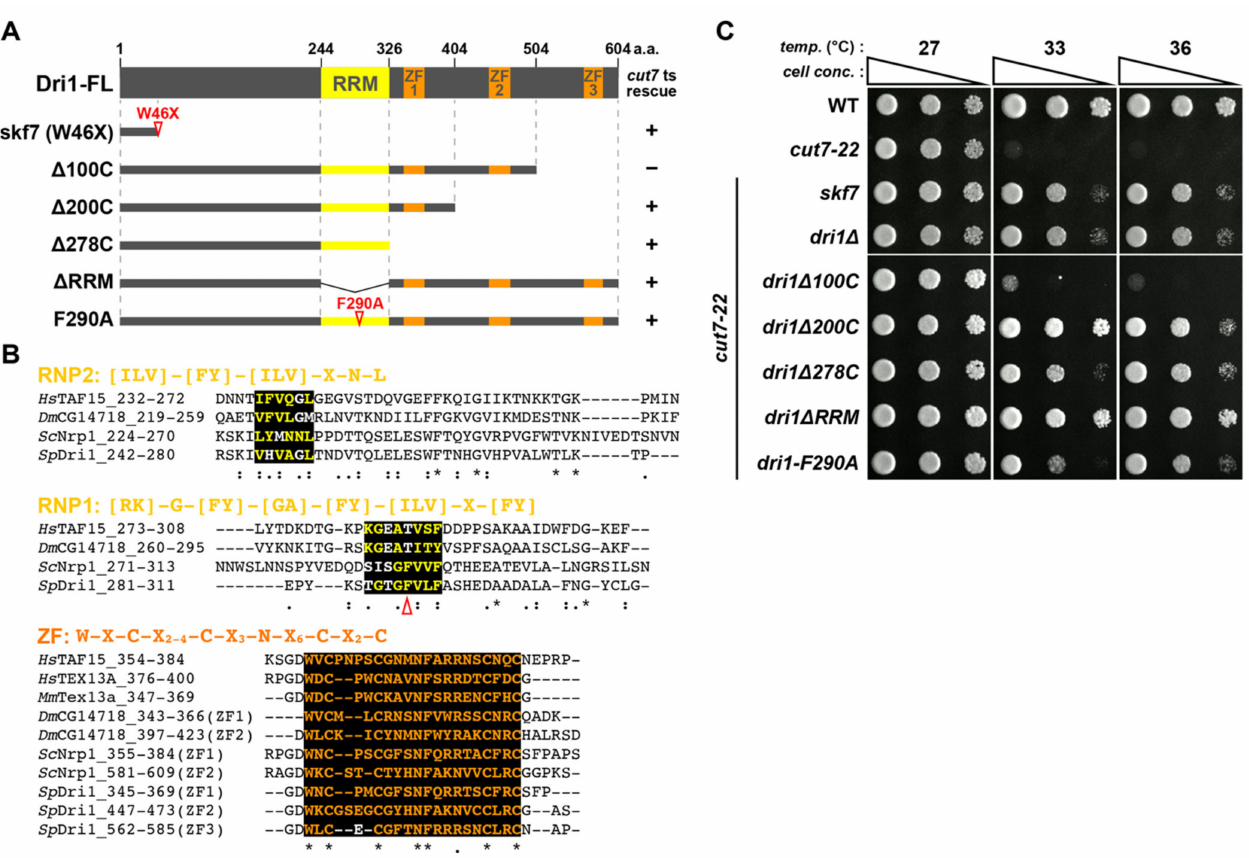
Figure 1. Systematic truncation and mutation analysis of Dri1 highlights the importance of RRM and RanBP2-type ZF domains. ( A ) Schematic representation of full-length Dri1 (Dri1-FL), skf7 mutant (W46X), C-terminal truncation mutants ( ∆ 100C, ∆ 200C, and ∆ 278C), an RRM truncation mutant ( ∆ RRM) and an RRM point mutant (F290A). The plus or minus sign indicates “rescue” or “no rescue”, respectively, of the cut7-22 ts phenotype by each dri1 mutant. ( B ) Dri1 is a member of the Tex13 protein family and is conserved across different species. Amino acid sequences from the indicated species have been aligned using the Clustal W. Consensus amino acids for the RRM (RNP1 and RNP2) or the RanBP2-type zinc finger domain (ZF) are highlighted in yellow or orange letters on black background, respectively. The conserved sequences are highlighted using symbols (asterisk represents identical residues; colon represents highly conservative residues; period represents moderately conservative residues). The F290A mutation is shown with an open arrowhead. Positions of amino acids used for H. sapiens TEX13A (376–400), M. musculus Tex13a (347–369), D. melanogaster CG14718 (219–295, 343–366 and 397–423), S. cerevisiae Nrp1 (224–313, 355–384 and 581–609), S. pombe Dri1 (242–311, 345–369, 447–473 and 562–585). GenBank accession codes are as follows: Hs TEX13A, NP_001278206.1; Mm Tex13a, NP_080745.2; Dm CG14718, NP_650107.1; Sc Nrp1, NP_010114.1; Sp Dri1, NP_593574.1. The sequences of H. sapiens TAF15 (232–308, 354–384) obtained from GenBank (NP_631961.1) are also aligned as reference sequences. ( C ) Spot test. Indicated strains were serially (10-fold) diluted, spotted onto rich YE5S plates and incubated at various temperatures for 2–3